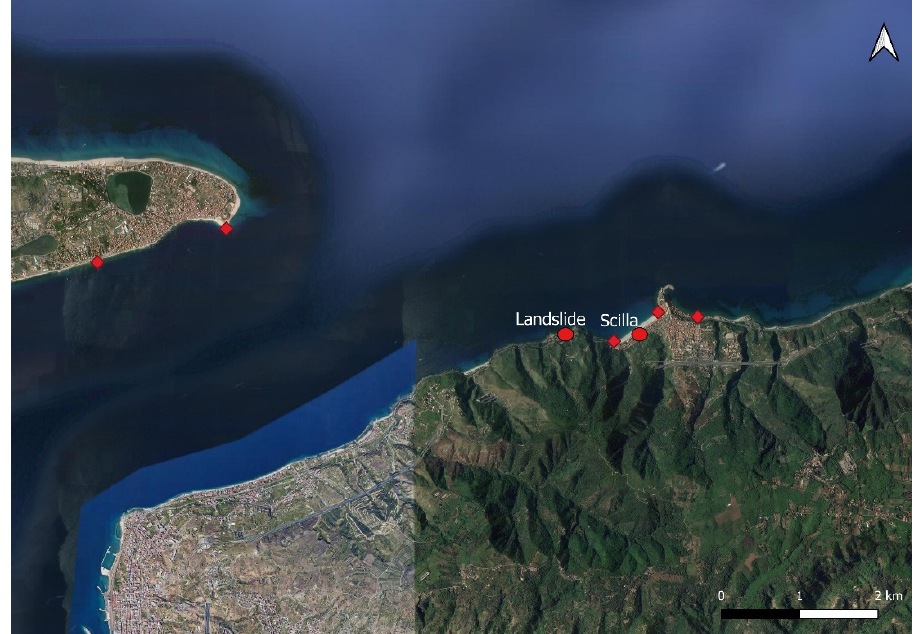
Figure 21. Points where the elevation of the wave was evaluated. In green, is the area of Chianalea; in red, Scilla Sud; in orange, Scilla Nord. The arrow indicates the position of the landslide and the point where the wave elevation was evaluated (source QGIS).